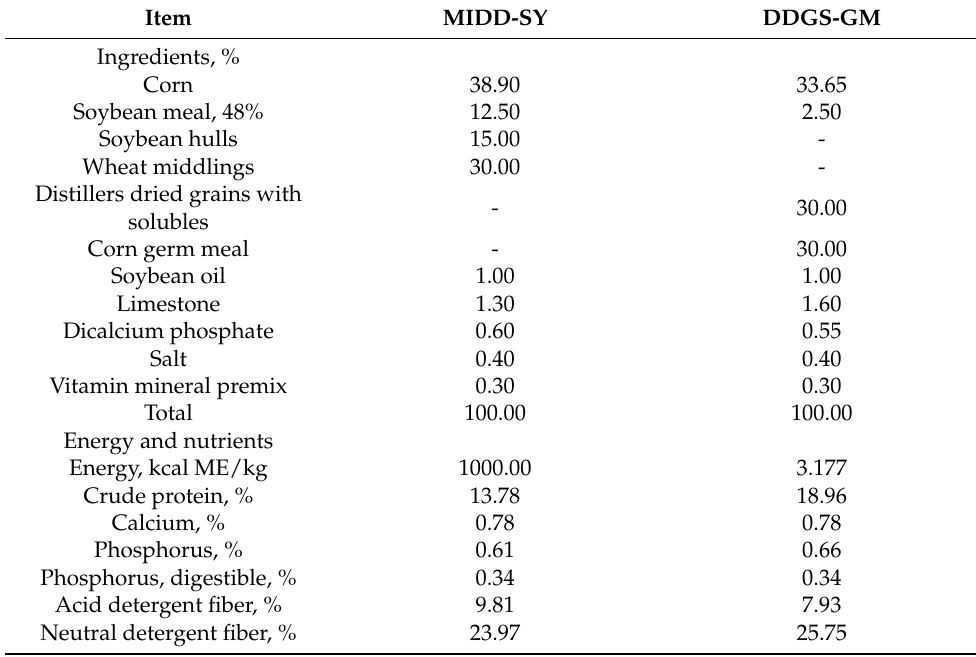
Table 1. Ingredient composition and nutrient levels of the gestational diets 1